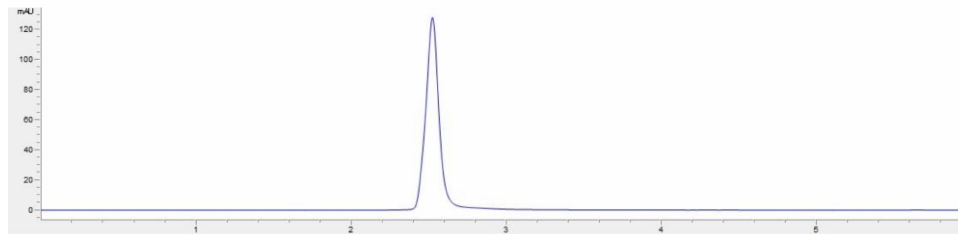
Figure A4. HPLC chromatogram of CUR